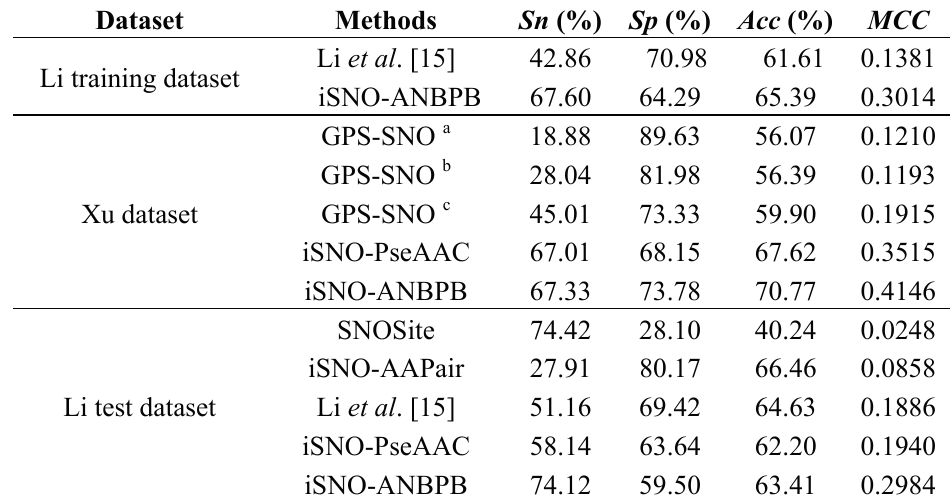
Table 2. Performance comparison of different computational approaches on different datasets.